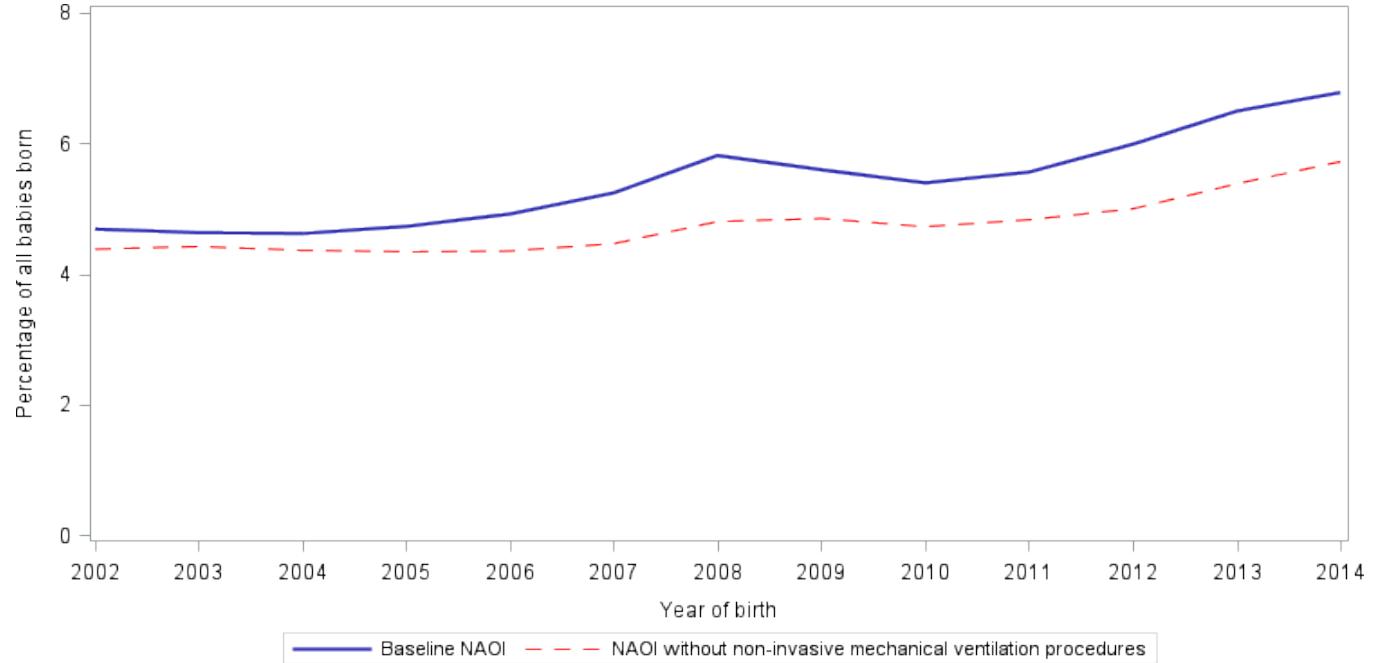
Supplementary Figure 1: Sensitivity analysis of non-invasive ventilation procedures on the incidence of severe or medically significant neonatal morbidity, assessed by relevant codes from neonatal adverse outcome indicator